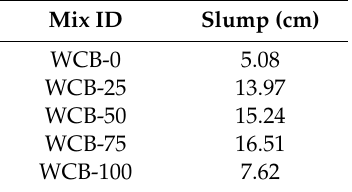
Table 5. Workability of Waste Carbon Black (WCB) Lightweight Concrete.